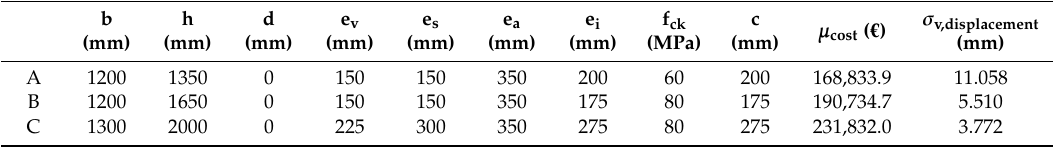
Table 11. Comparison of di ff erent designs of the Pareto Frontier with a 20% variation of the prestressing